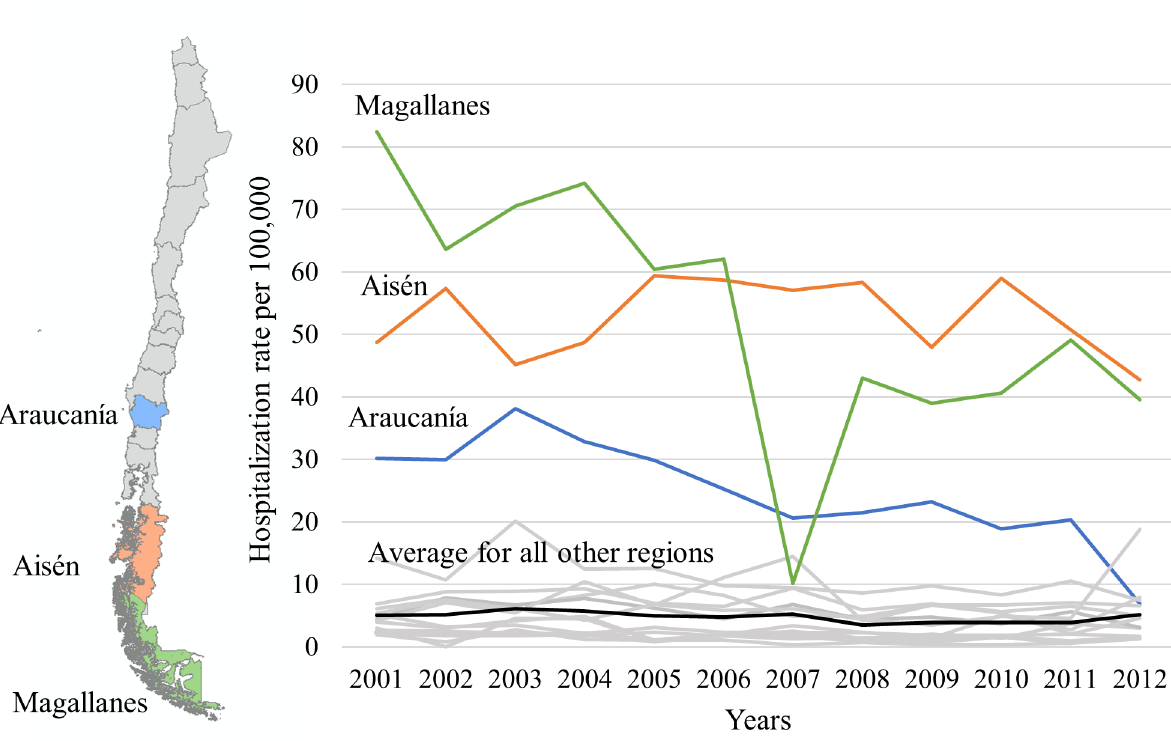
Fig 1. Map and trend of hospitalization rate by region from 2001to 2012 (per 100,000). The map was created by authors using ArcGIS Desktop (ESRI 2011. ArcGIS Desktop: Release10.3. Redlands,CA: Environmental Systems ResearchInstitute.) and the base layer was obtainedby NationalLibrary of Congressof